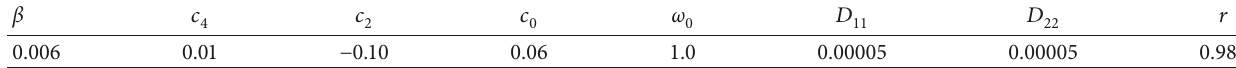
Table 5: Parameter values used in simulation.